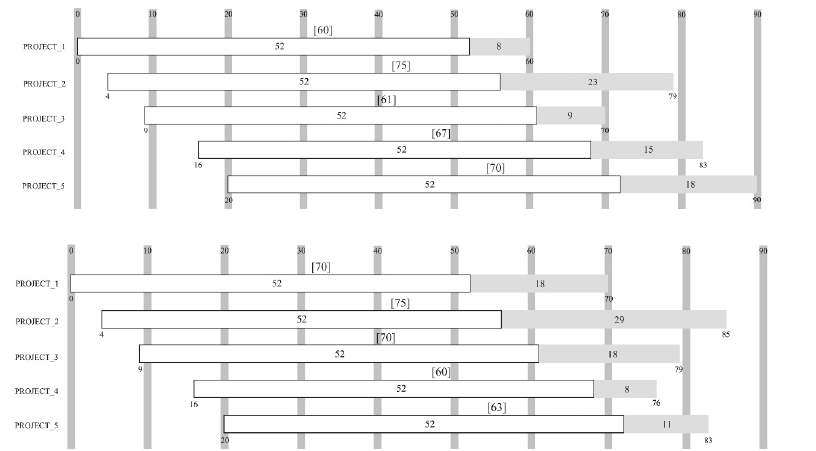
Fig. 8. Comparison of the schedules obtained in the two